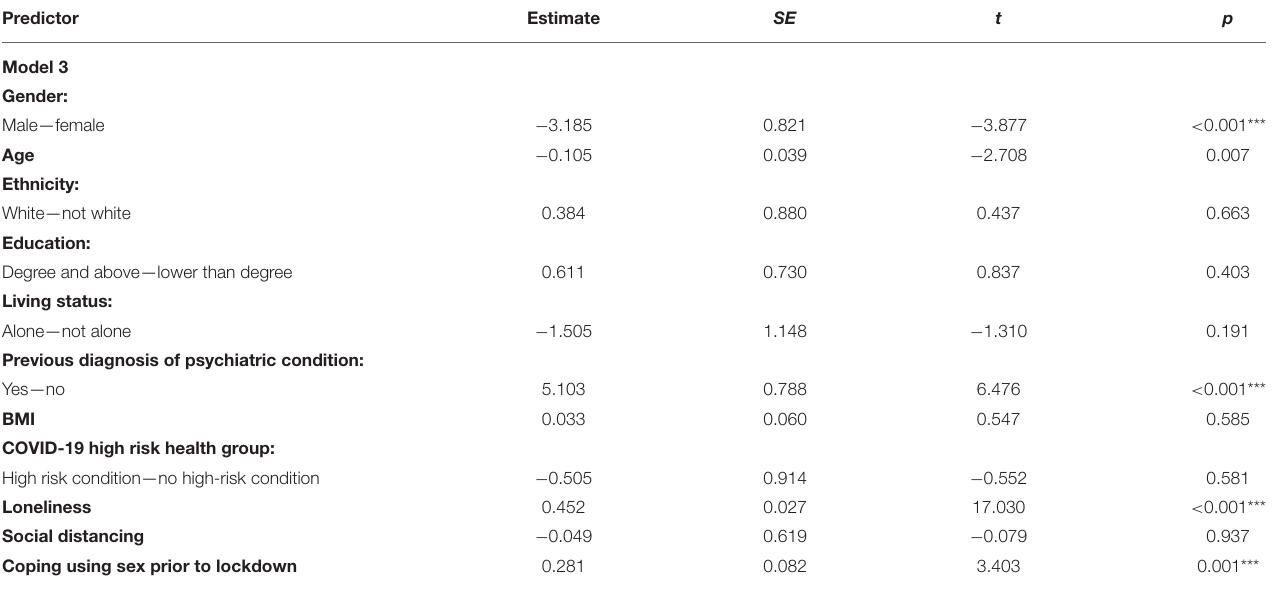
TABLE 6 | Results of multiple linear regression on DASS-21 total score during lockdown. Predictor Estimate SE t p Model